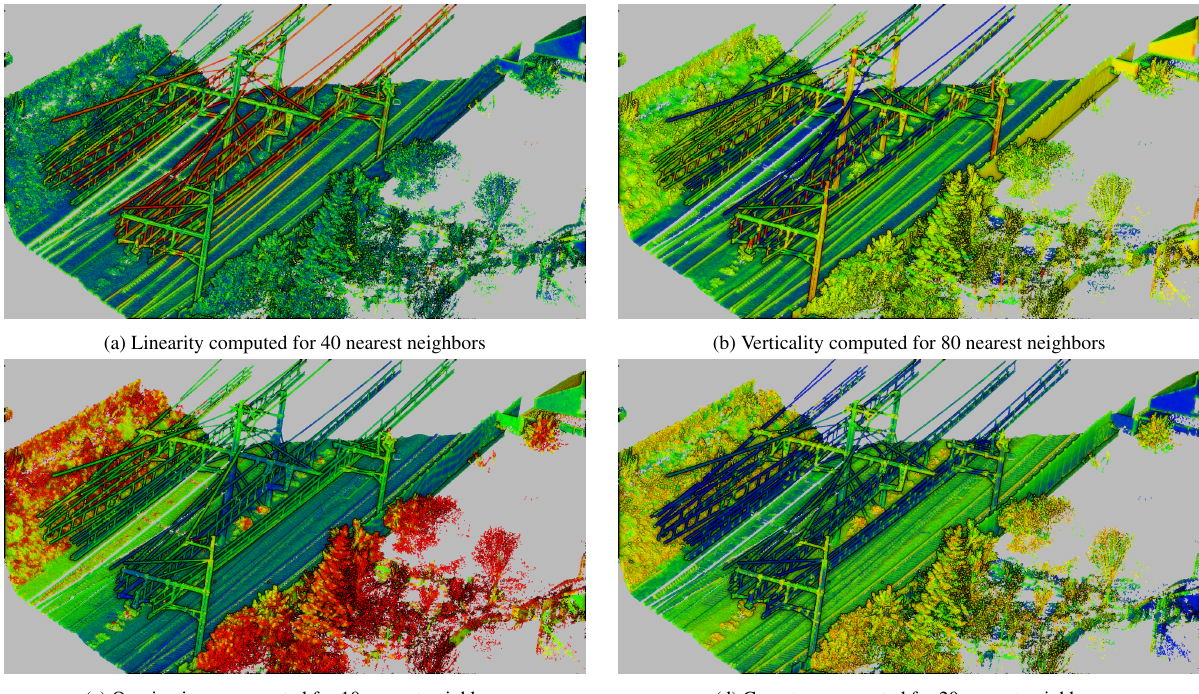
Figure 1. Illustration of the computed descriptors and their complementarity. Color ranges from blue (lowest values) to red (highest values).